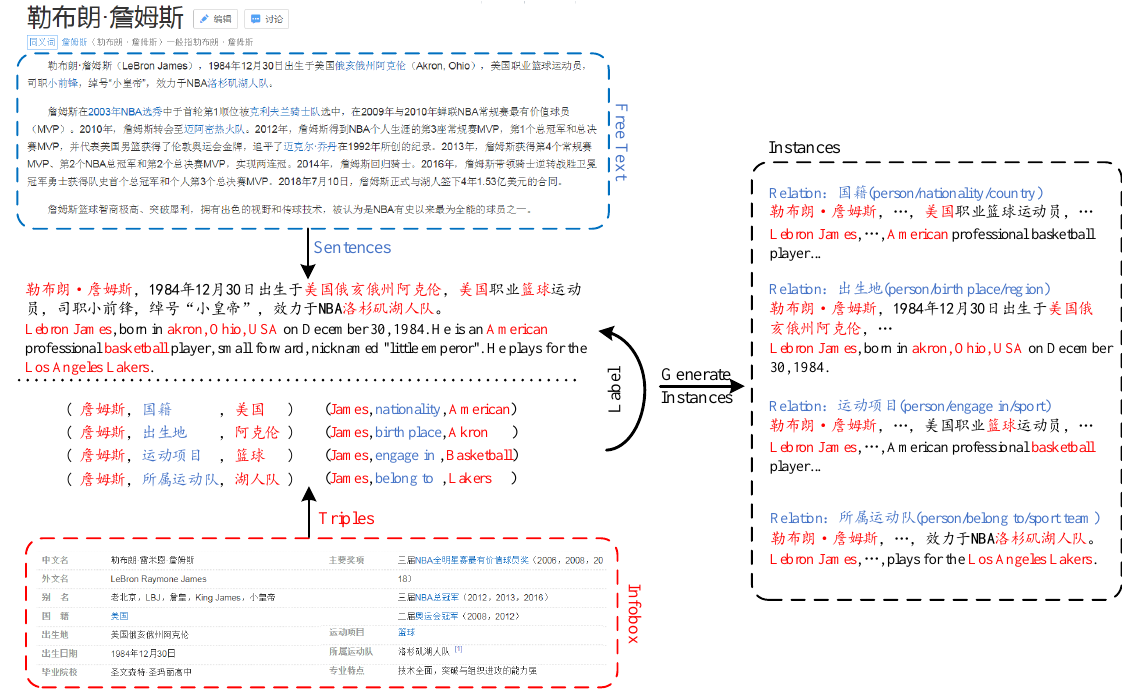
Figure 2. Extract labeled instances from